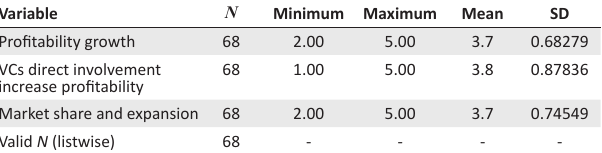
TABLE 4: SPSS descriptive statistics measurement of small- and medium-sized enterprises’ growth using profitability growth. Variable